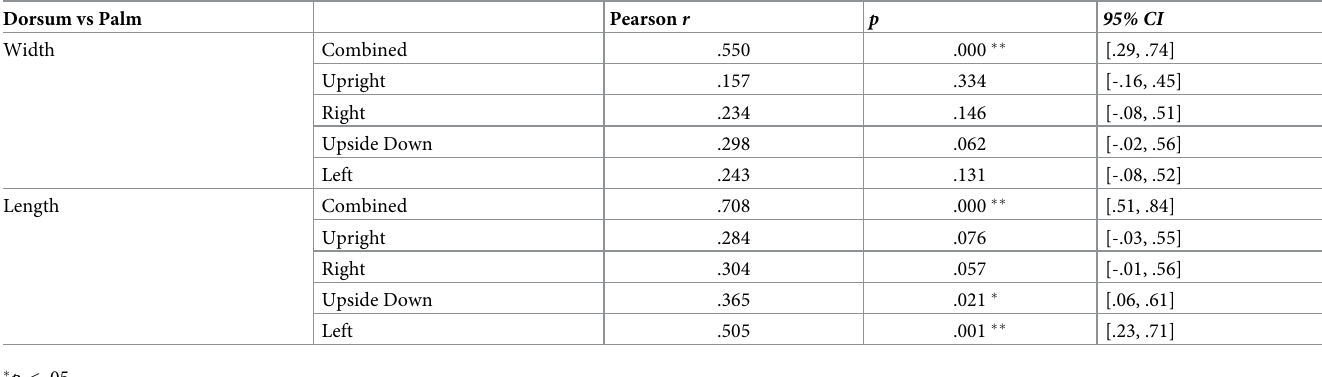
Table 1. Correlations between the perceived size of the dorsum and palm (N = 40). Dorsum vs Palm